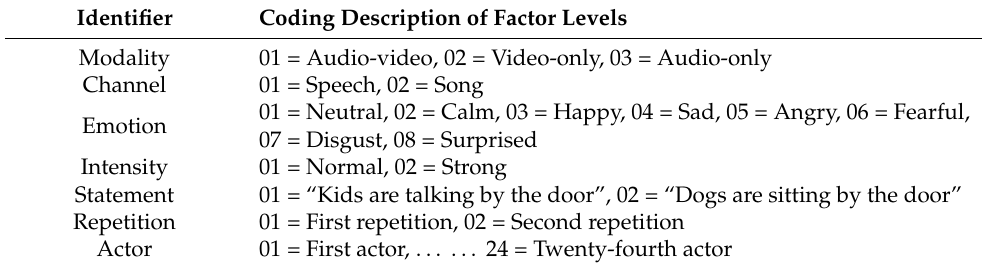
Table 5. Identifiers of RAVDESS